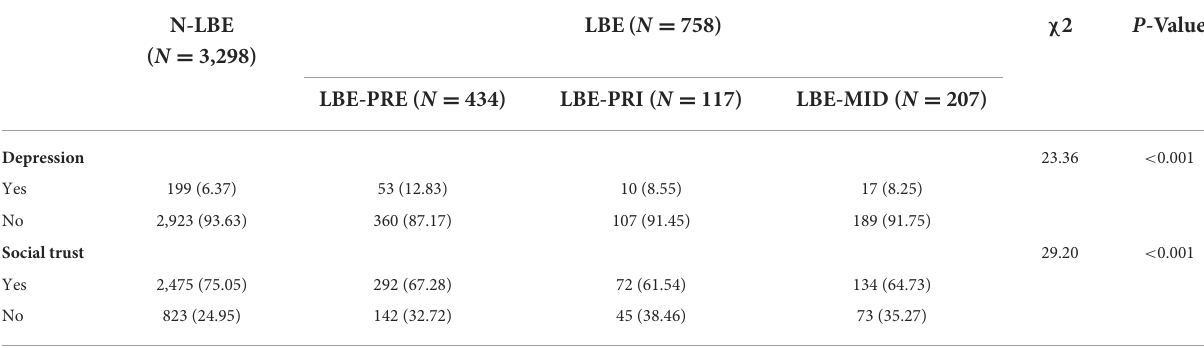
TABLE 3 Depression and social trust by left-behind experience stage, N